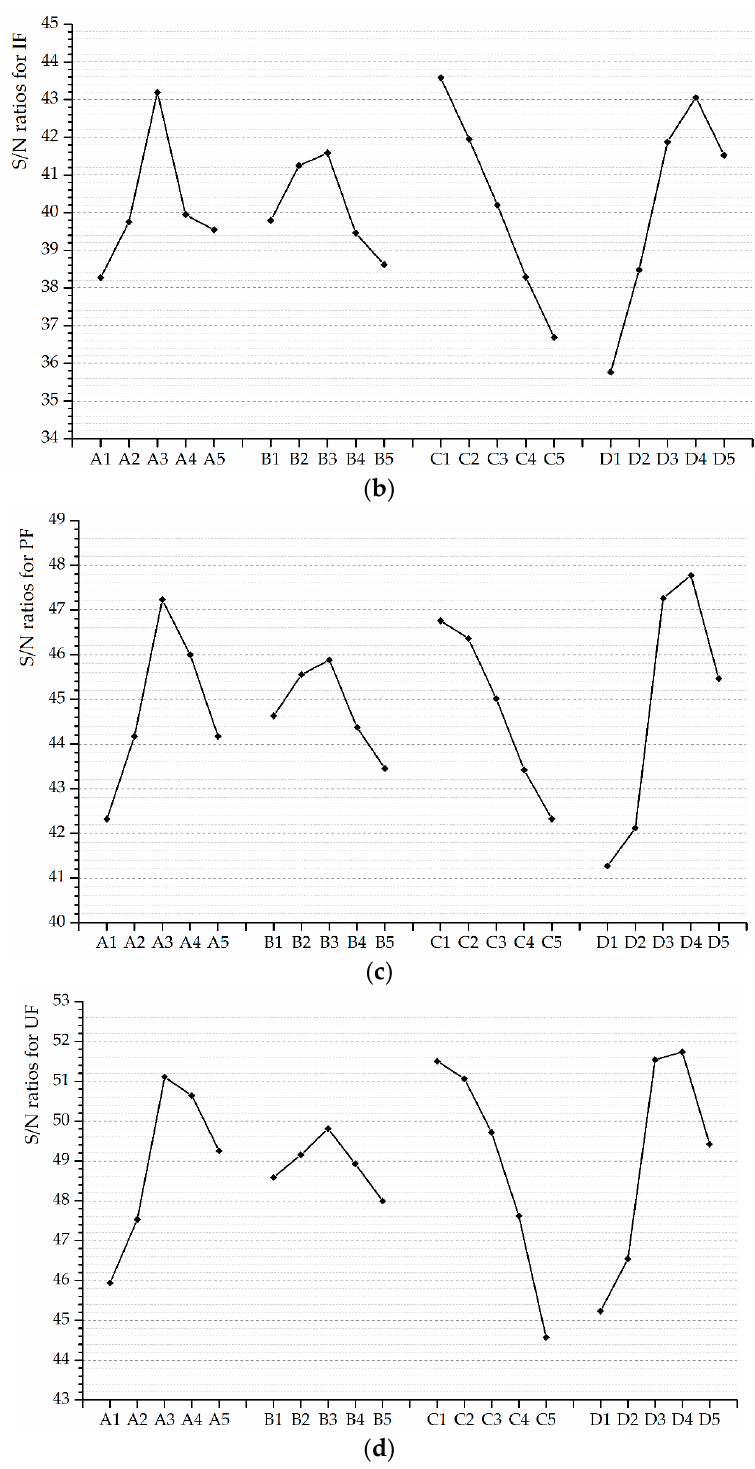
Figure 16. S/N ratios for: ( a ) Flexural strength; ( b ) IF index; ( c ) PF index; ( d ) UF index. Figure 16. S / N ratios for: ( a ) Flexural strength; ( b ) IF index; ( c ) PF index; ( d ) UF